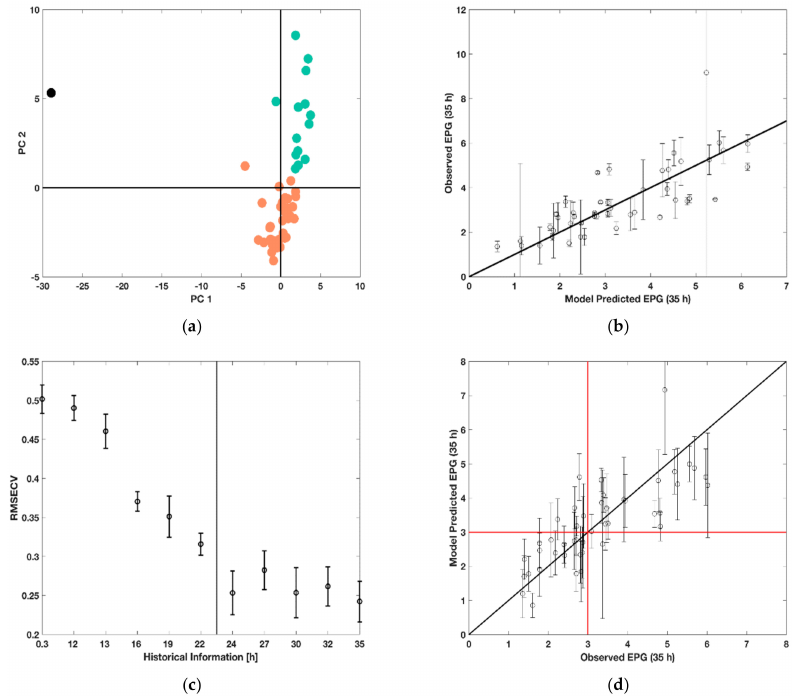
Figure 7. Real-time outlier identification and batch characterization using principal component analysis (PCA). ( a ) Clusters 1 (red circles) with 17 observations, cluster 2 (green circles) with 30 observations and the outlier (black circle) detected after 24 h of cultivation; ( b ) Prediction of a partial least square regression (PLSR) model using all history and variable selection against the experimental values of volumetric EPG activity at 35 h. ( c ) Root mean square error of cross validation (RMSECV) (see Section 2.10) of the PLSR models built based on different amounts of history (with variable selection). ( d ) Experimental values of volumetric EPG activity at 35 h of batch against the model prediction built using the history until 24 h (with variable